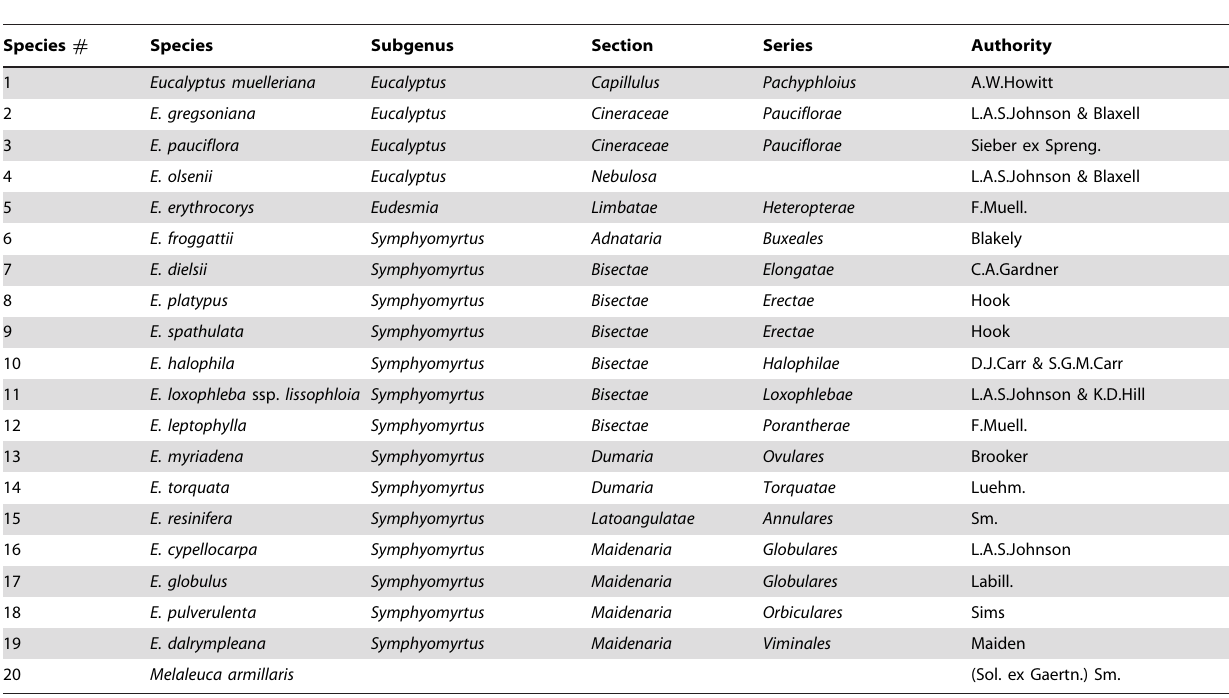
Table 1. Eucalyptus and Melaleuca species surveyed for the presence of non-volatile compounds in the lumen of foliar secretory cavities {